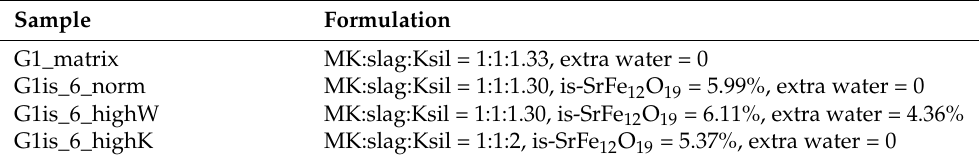
Table 3. Composition of the samples used for electrical